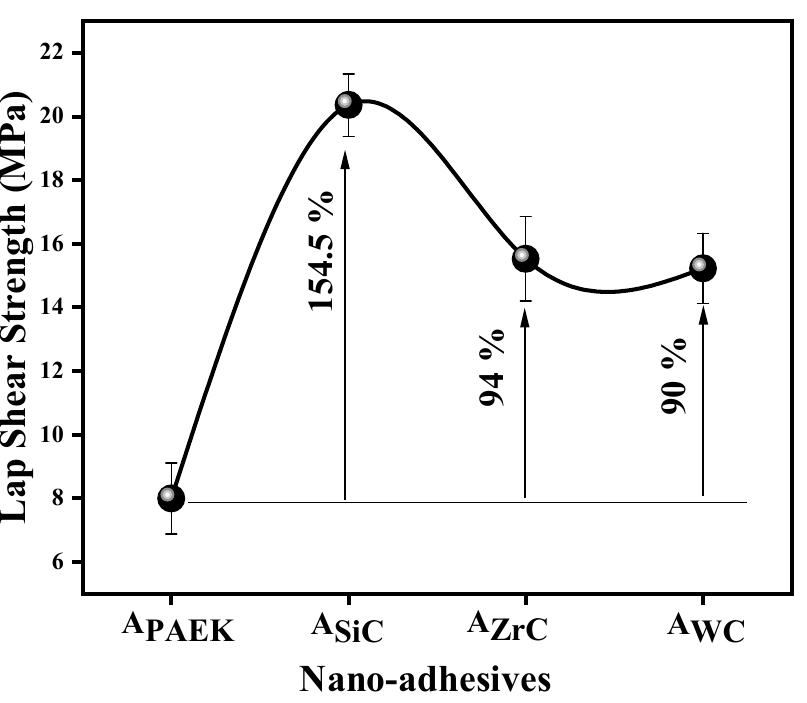
Figure 11. Lap shear strength of adhesives.